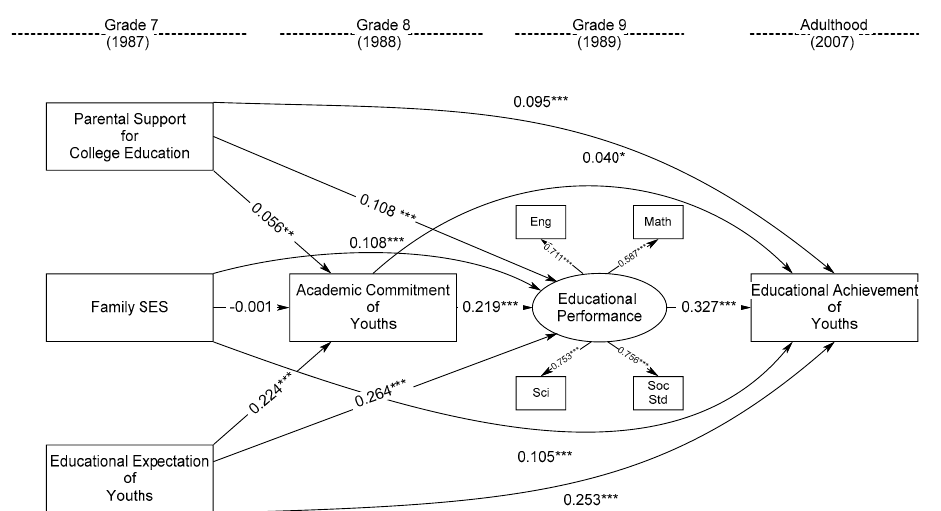
Figure 2. Standardized Effects of Parental Support for College Education, Family SES, and Educa-